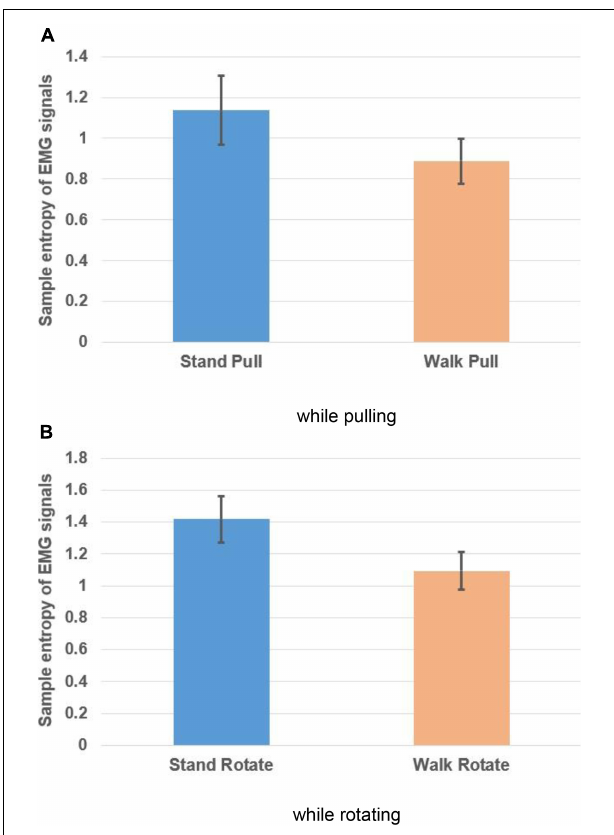
FIGURE 10 | Sample entropy of EMG signals in walking and standing while pulling (A) and rotating (B) . Error bars indicate standard deviation.